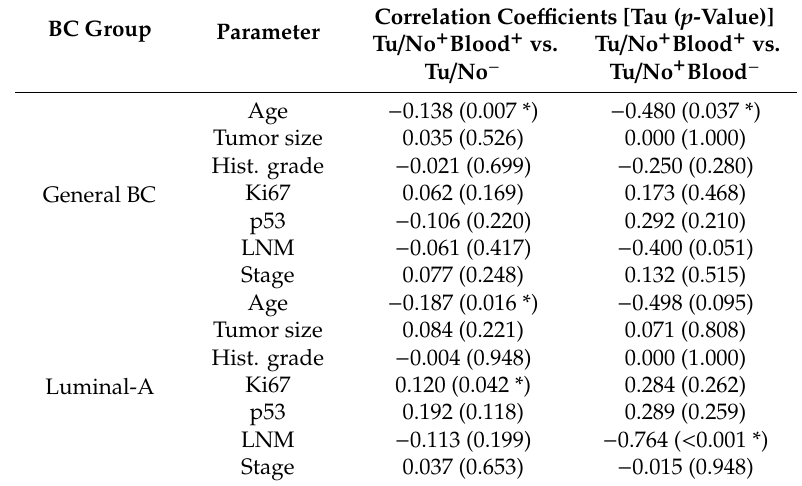
Table 4. Correlation between MMTV-like env in peripheral blood and clinicopathological